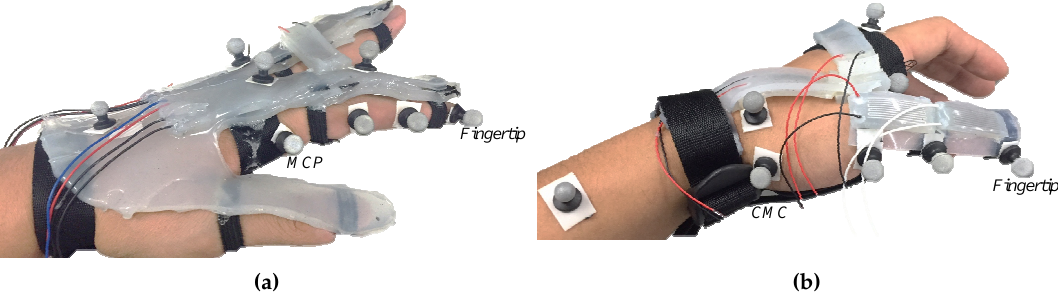
Figure 13. Experimental setup to verify the 3-D finger motion: ( a ) Attached markers on the index; ( b ) Attached markers on the